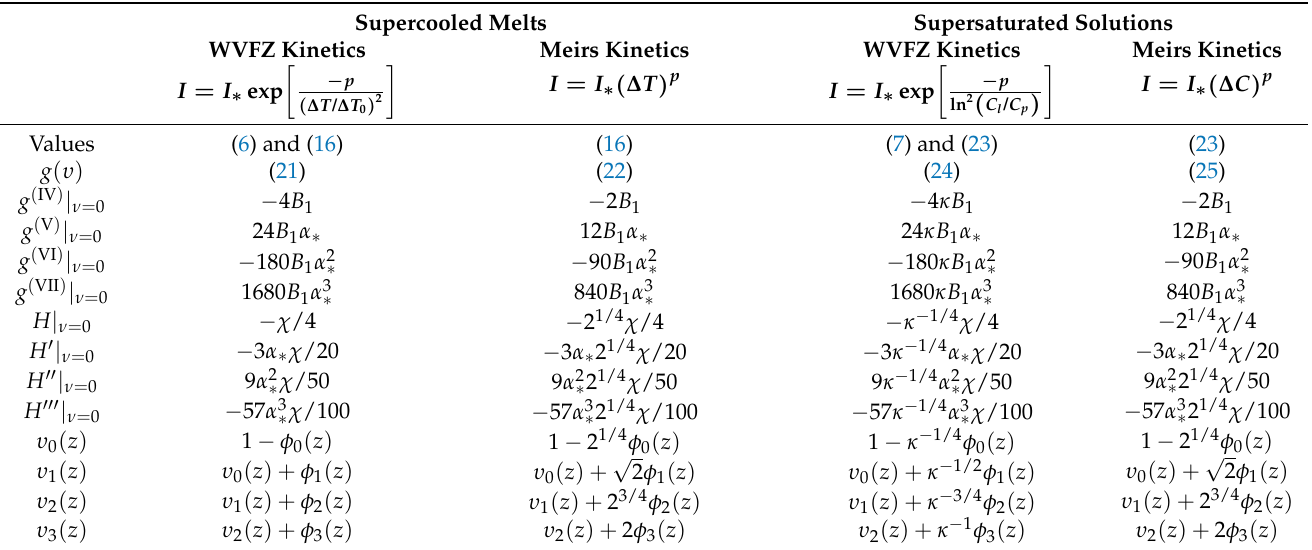
Table 1. Functions and parameters of the analytic solution for various kinetics. Here z = z ( ξ ( t )) = 1 + 2 α ∗ ξ ( t ) , and φ 0 , φ 1 , φ 2 and φ 3 are given